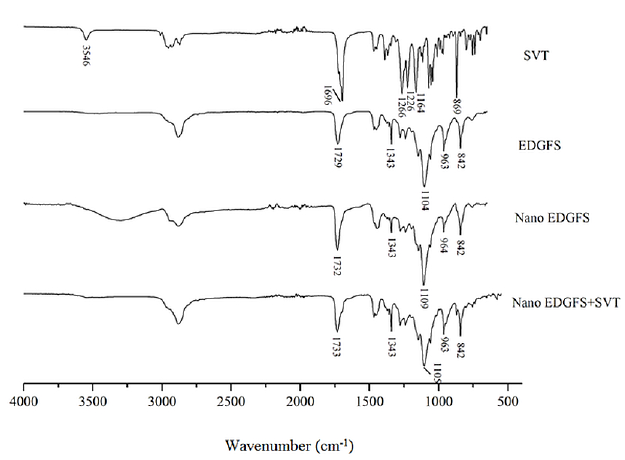
FIGURE 3 - Comparison of absorption spectra in the infrared region for simvastatin (SVT), Eudragit ® FS30D (EDGFS), unloaded Eudragit ® FS30D nanoparticles (Nano EDGFS) and simvastatin-loaded Eudragit ® FS30D nanoparticles; (Nano